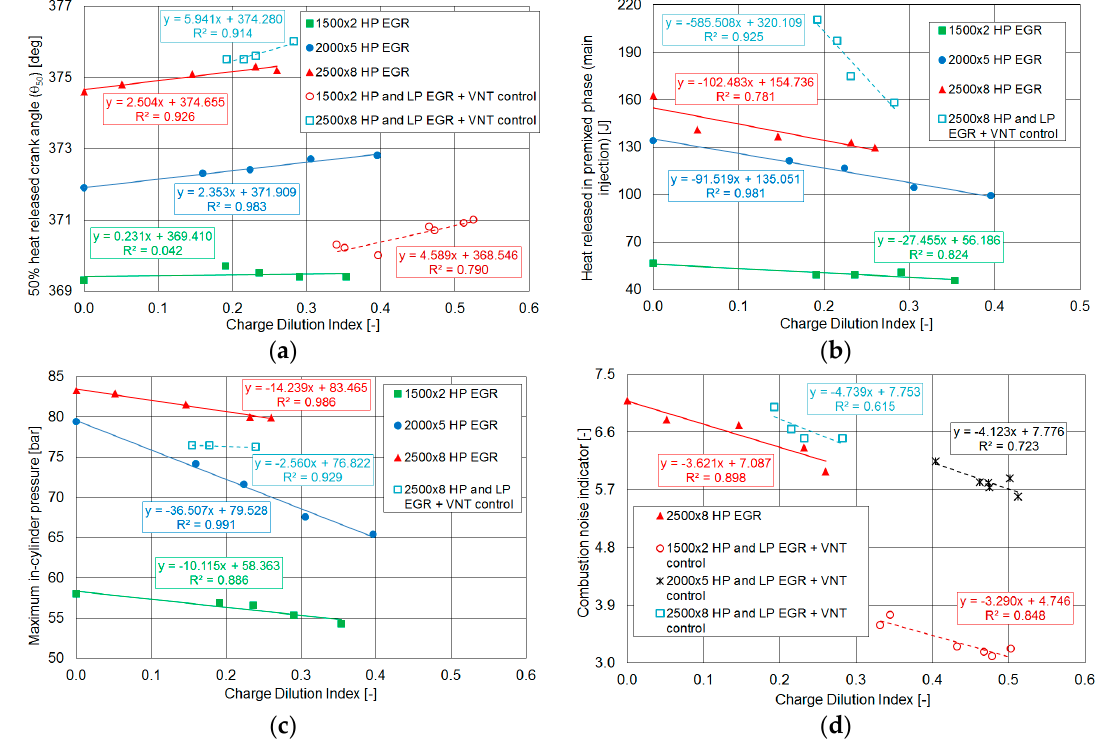
Figure 6. Link between Charge Dilution Index and θ 50 ( a ), HR premix ( b ), p MAX ( c ) I n ( d ) in different test sets.